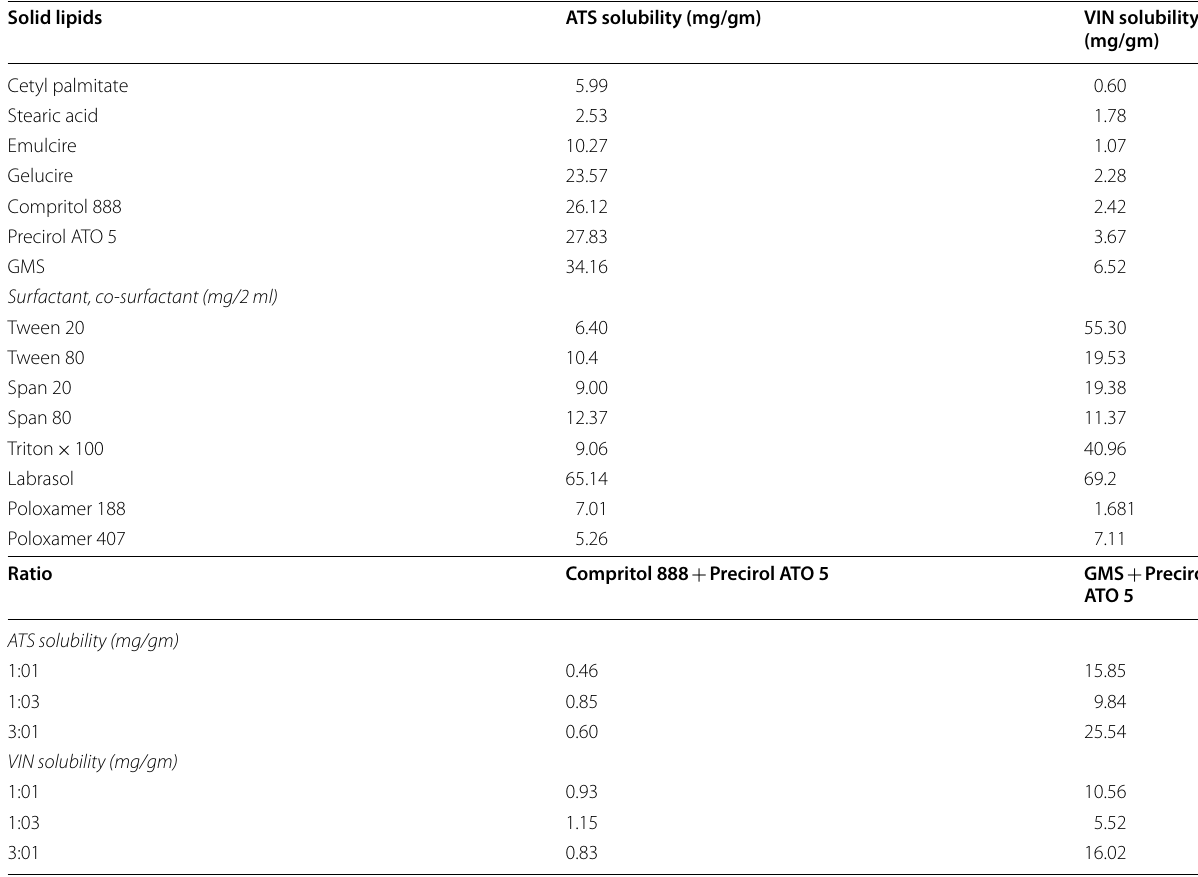
Gm, gram; ml, milliliter